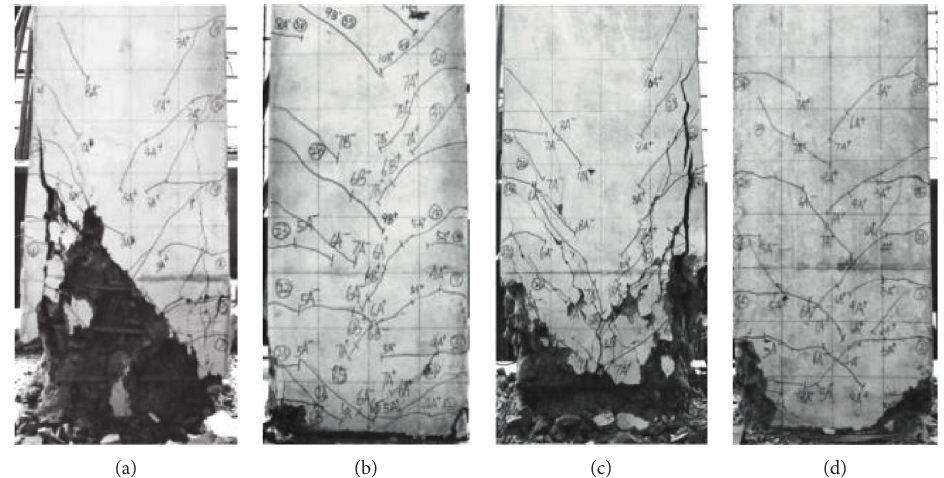
Figure 6: Comparison of the failure patterns of the concrete beams reinforced with stainless steel bars and ordinary steel bars: (a) SKC-1; (b) SKC-5; (c) DBC-1; (d) DBC-2. With stainless steel bars